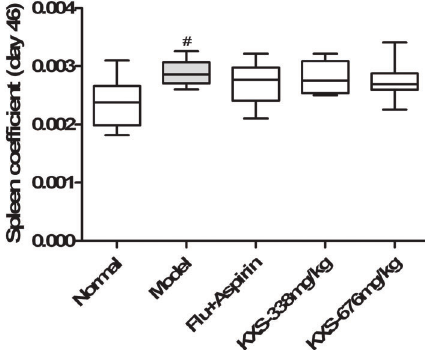
Figure 3 . Effects of Kai-Xin-San (KXS) on spleen coef fi cient in fl uoxetine-resistant depression (FRD) rats exposed to chronic and unpredictable mild stress model and randomly divided into four groups: FRD model control (Model), oral fl uoxetine and aspirin (Flu + Aspirin), oral KXS at a dose of 338 mg/kg, and 676 mg/kg. Data are reported as means ± SD, n=12. # P o 0.05 compared to untreated Normal